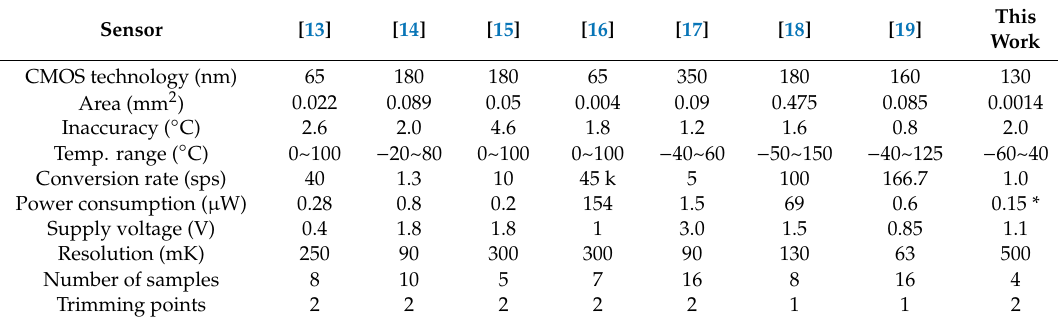
Table 1. Performance